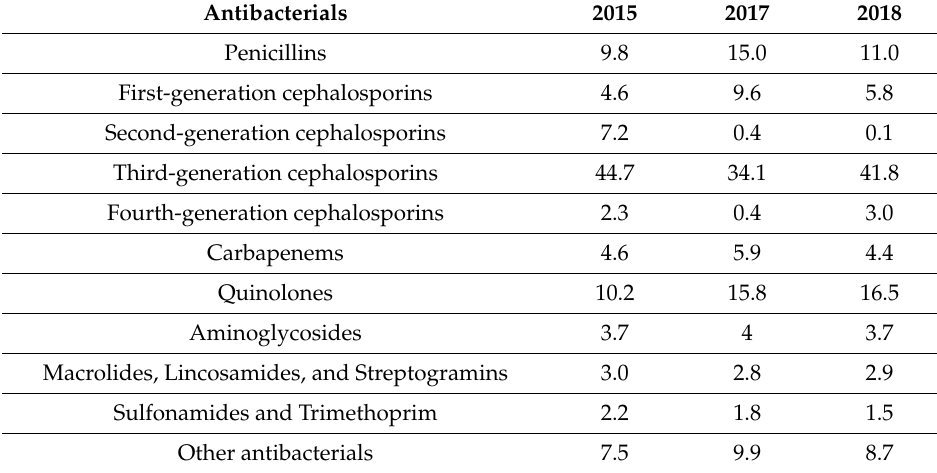
Table 4. Overall proportional use of systemic antibacterials (ATC J01), %.